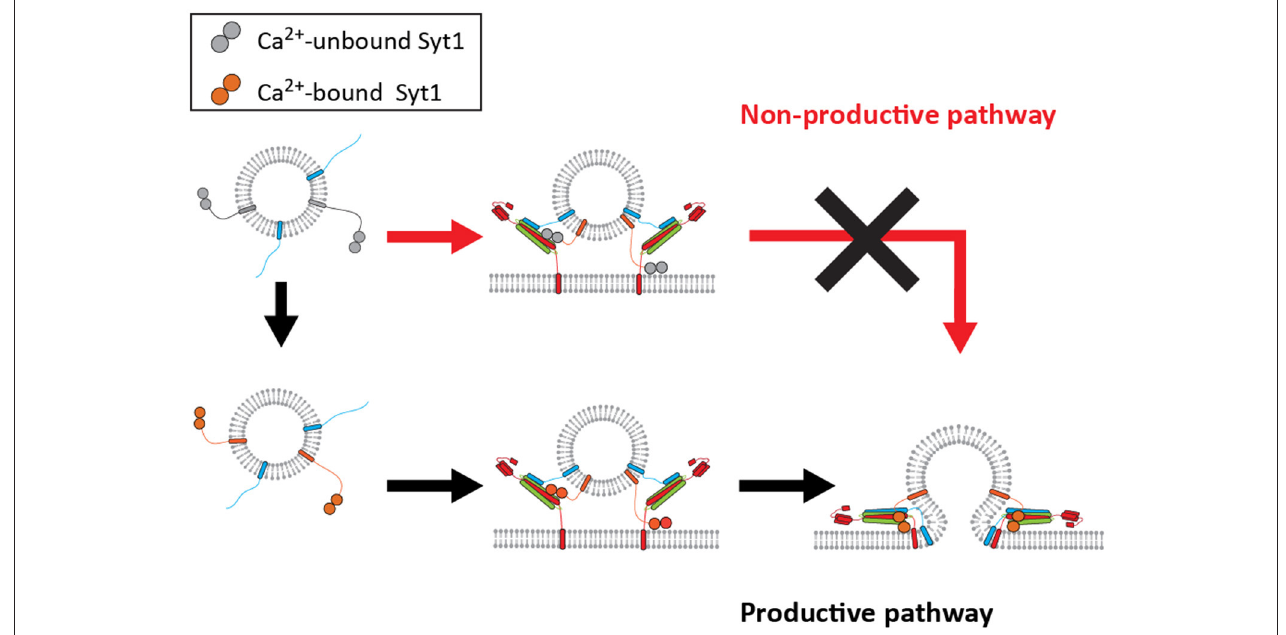
FIGURE 5 | A mechanistic model for productive and non-productive pathway for fast membrane fusion. The productive pathway (black arrows) requires binding of Syt1 with Ca 2 + prior to its interaction with either t-SNAREs or the lipid membrane for fast membrane fusion. However, the vesicles do not respond to Ca 2 + if they have already docked, thus being trapped in the non-productive pathway (red